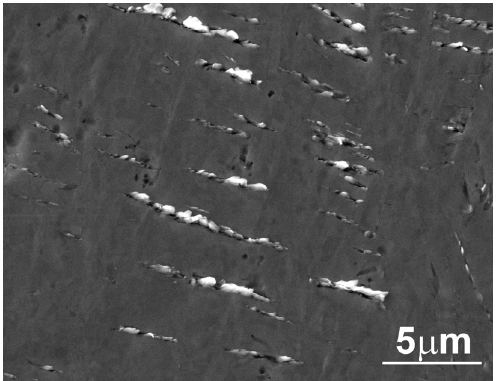
Figure 10: Cyclic slip band on the surface of UFG Cu loaded in HCF region.